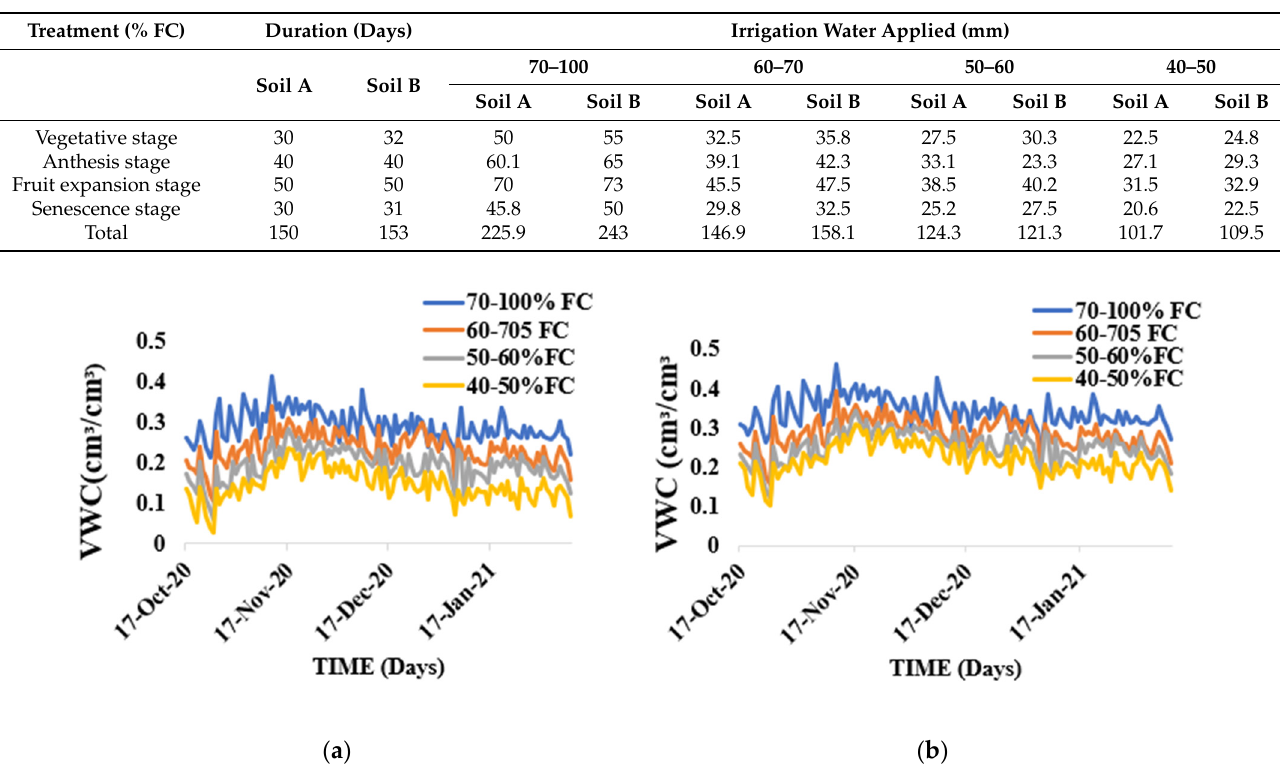
Figure 2. Disparity in soil moisture content during the growing season for sandy loam soil and silty loam soil. ( a ) Sandy loam soil, ( b ) silty loam soil.